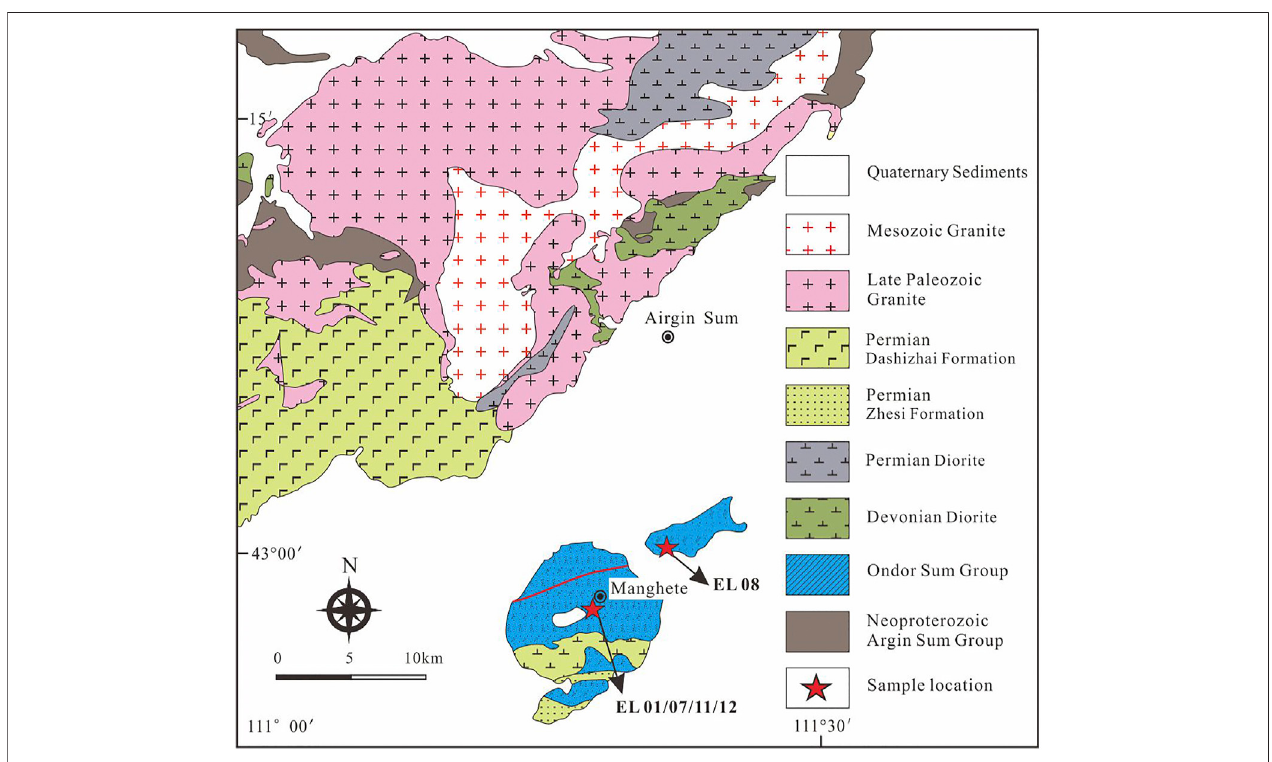
FIGURE 2 | Geological map of Airgin Sum area (modi fi ed after Li et al., 2014) showing lithological distribution of the Ondor Sum Group and sampling localities.